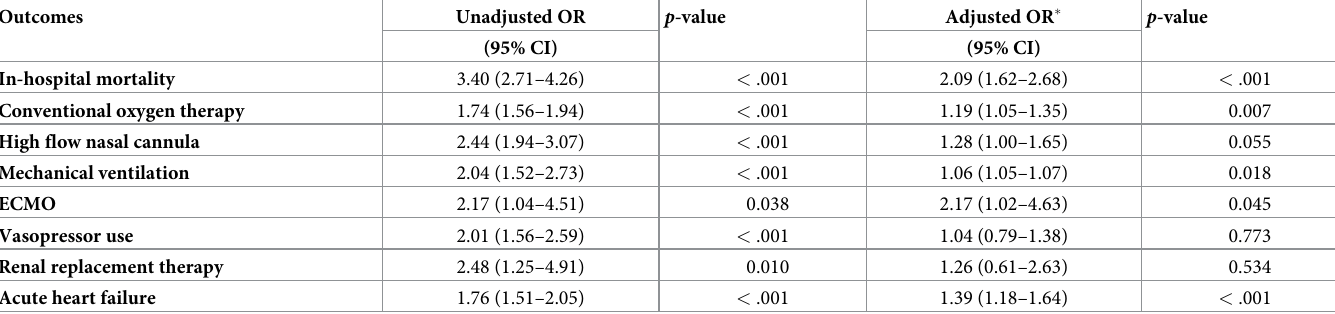
Table 3. Risks of outcomes among immunocompromised patients after inverse probability of treatment weighting.